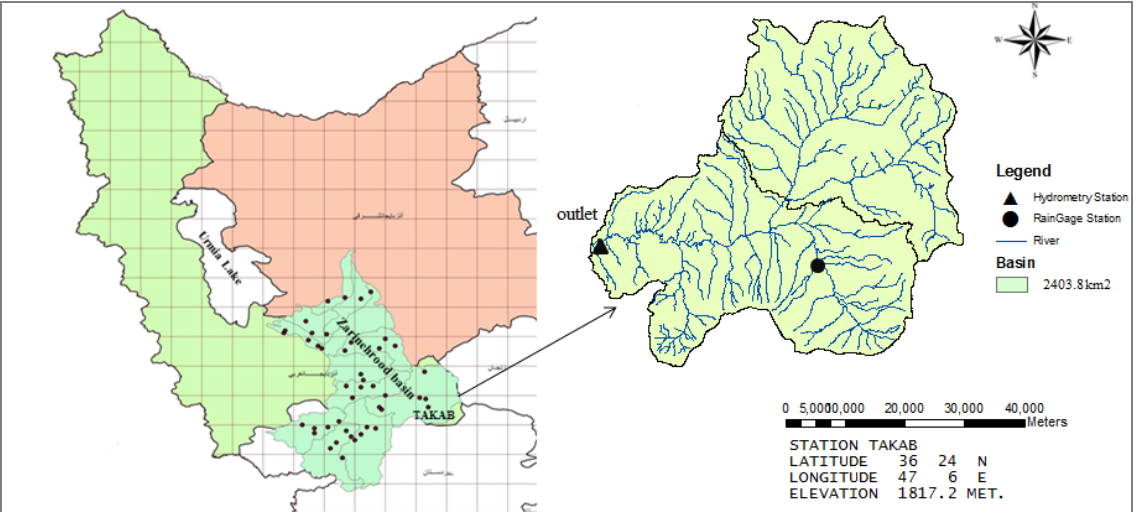
Figure 1. The study area of Sarough-Chay river sub-basin